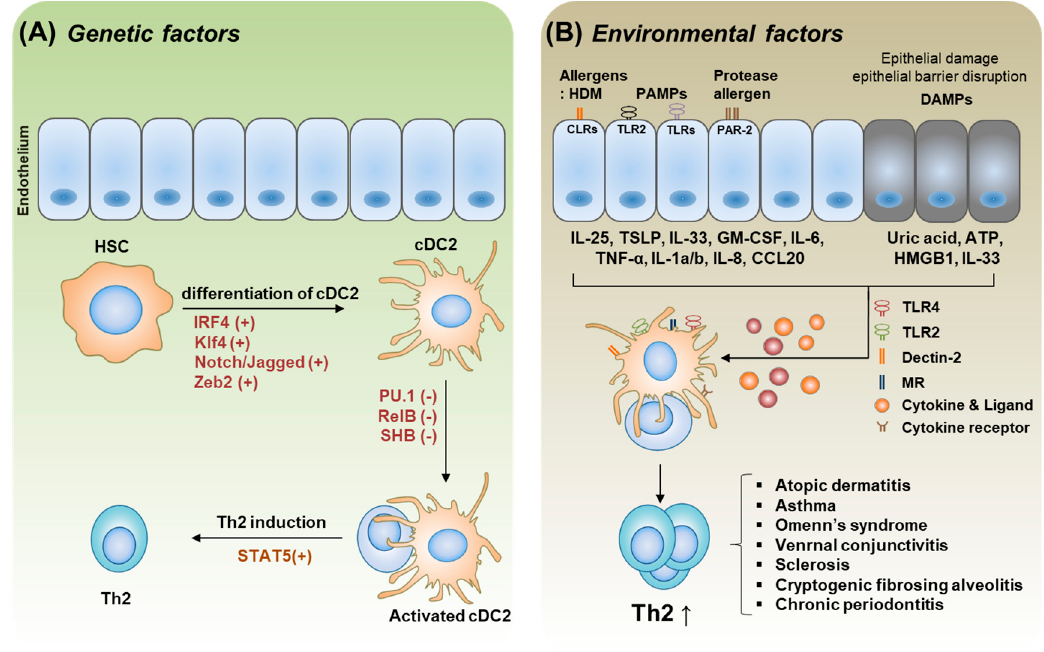
Figure 3. Genetic factors and environmental factors which are involved in the development of the cDC2 phenotype, eventually mediating Th2 polarization. ( A ). Genetic factors involved in each stage of cDC2 differentiation and cDC2-mediated Th2 development. Major transcription factors required for cDC2 development are marked in red and (+) as positive regulators, and (-) as negative regulators in the development of cDC2 and in controlling DC-mediated Th2 polarization. ( B ). Environmental factors affecting cDC2 priming and cDC2-mediated Th2 polarization and associated immune disorders. Allergens, PAMPs, and DAMPs, and their receptors on the ECs and DCs are indicated. Cytokines and ligand molecules secreted from damaged or primed ECs and their recognition receptors on DCs are indicated. Primed cDCs stimulate Th2 responses, occasionally leading to Th2 immune disorders. Details are described in the text.